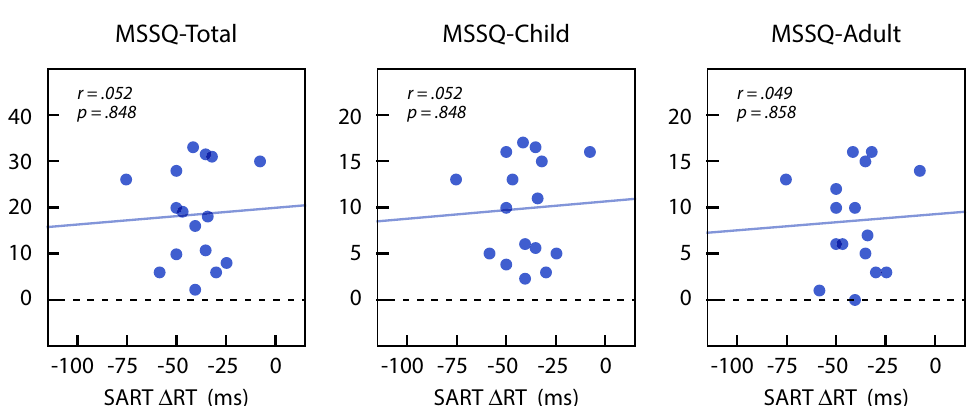
Fig. 5 Self-reported motion sickness susceptibility (MSSQ) of individual subjects in Experiment 1 plotted as a function of their attentional allocation scores derived from SART. The attentional allocation score is the mean difference in reaction times for peripheral and central targets: ΔRT RTCVF RTPVF. Positive values of ΔRT correspond to more attention to the periphery. Lines show the regression fits. The left graph plots the = − total MSSQ scores, and the middle and right graphs plot the MSSQ child and MSSQ adult